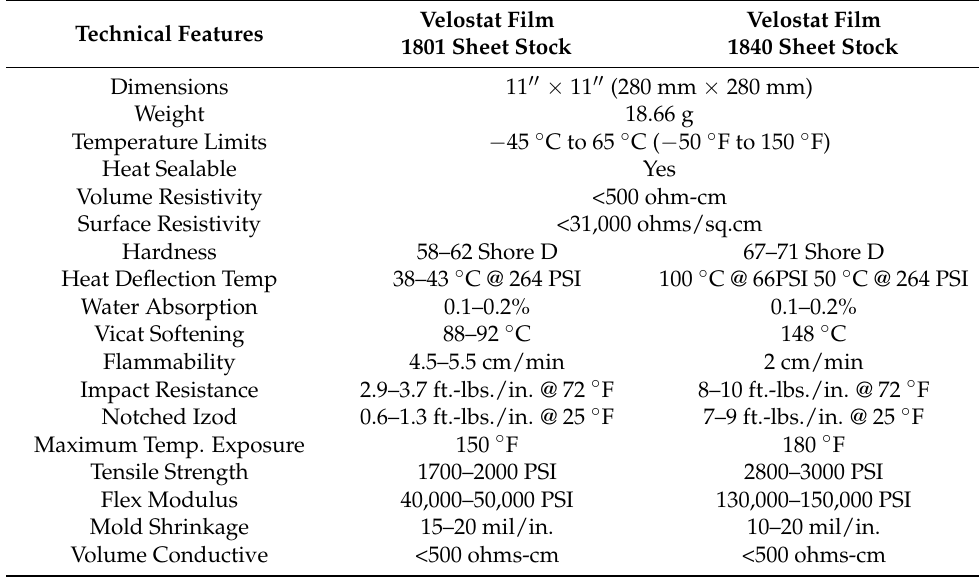
Table 2. Technical characteristics of 1801 Sheet Stock and 1801 Sheet Stock of Velostat film.